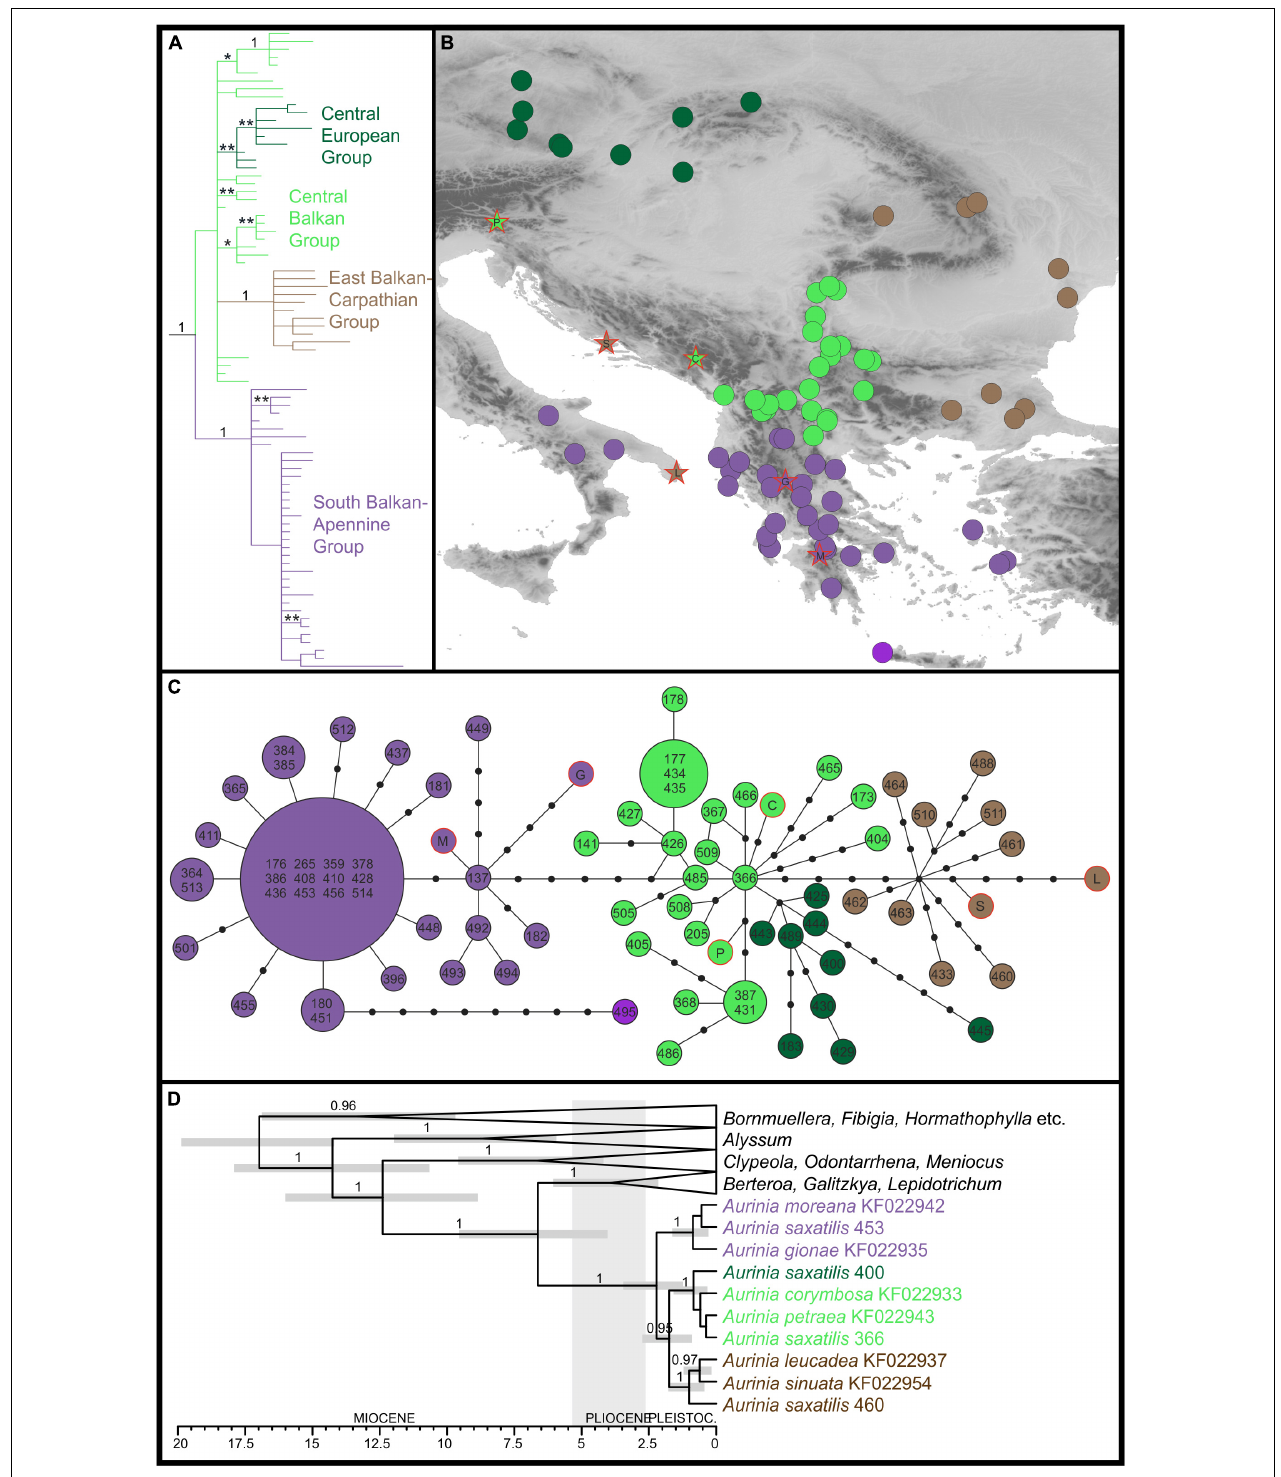
FIGURE 1 | Phylogenetic relationships inferred by plastid ndh F sequences of Aurinia saxatilis and related species. The colour codes indicate the main groups. (A) Simplified Bayesian consensus phylogram of the ingroup sequences (as shown in Supplementary Figure 4 ); numbers/asterisks above branches are PP values: *0.90–0.94; **0.95–0.99. (B) Geographic distribution of the main clade/haplotype groups inferred by the Bayesian analyses (A) and the statistical parsimony haplotype network (C) . (D) Simplified Bayesian chronogram indicating the time of divergences in Aurinia and in relation to related genera (for details, see Supplementary Figure 5 ). Population identifiers in (C,D) correspond to Supplementary Table 1 and Supplementary Figure 1 .